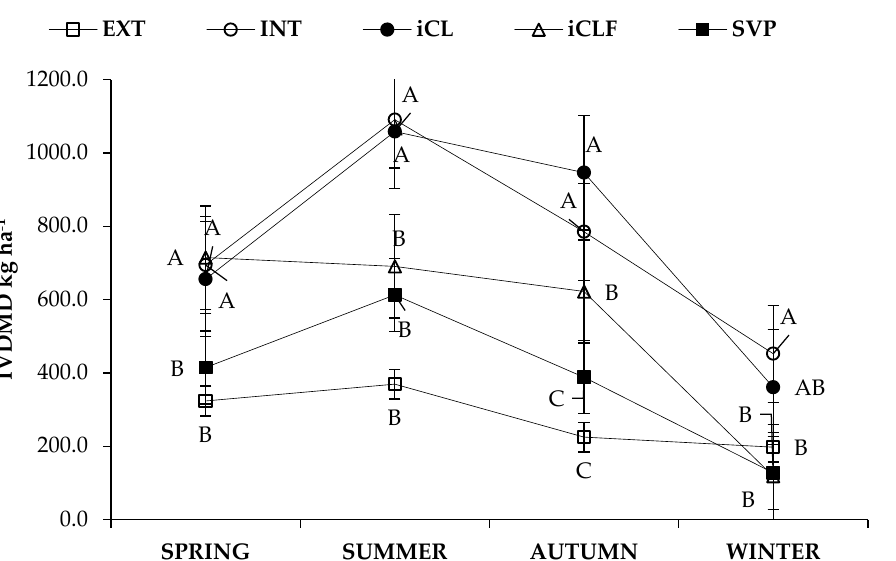
Figure A1. Dry mass availability during seasons from different livestock production systems (means of two years). Different letters in the same season differ from each other ( p < 0.05) according to the Tukey test. EXT: extensive; INT: intensive; iCL: integrated crop–livestock; iCLF: integrated crop– livestock–forest; iLF: integrated livestock–forest.